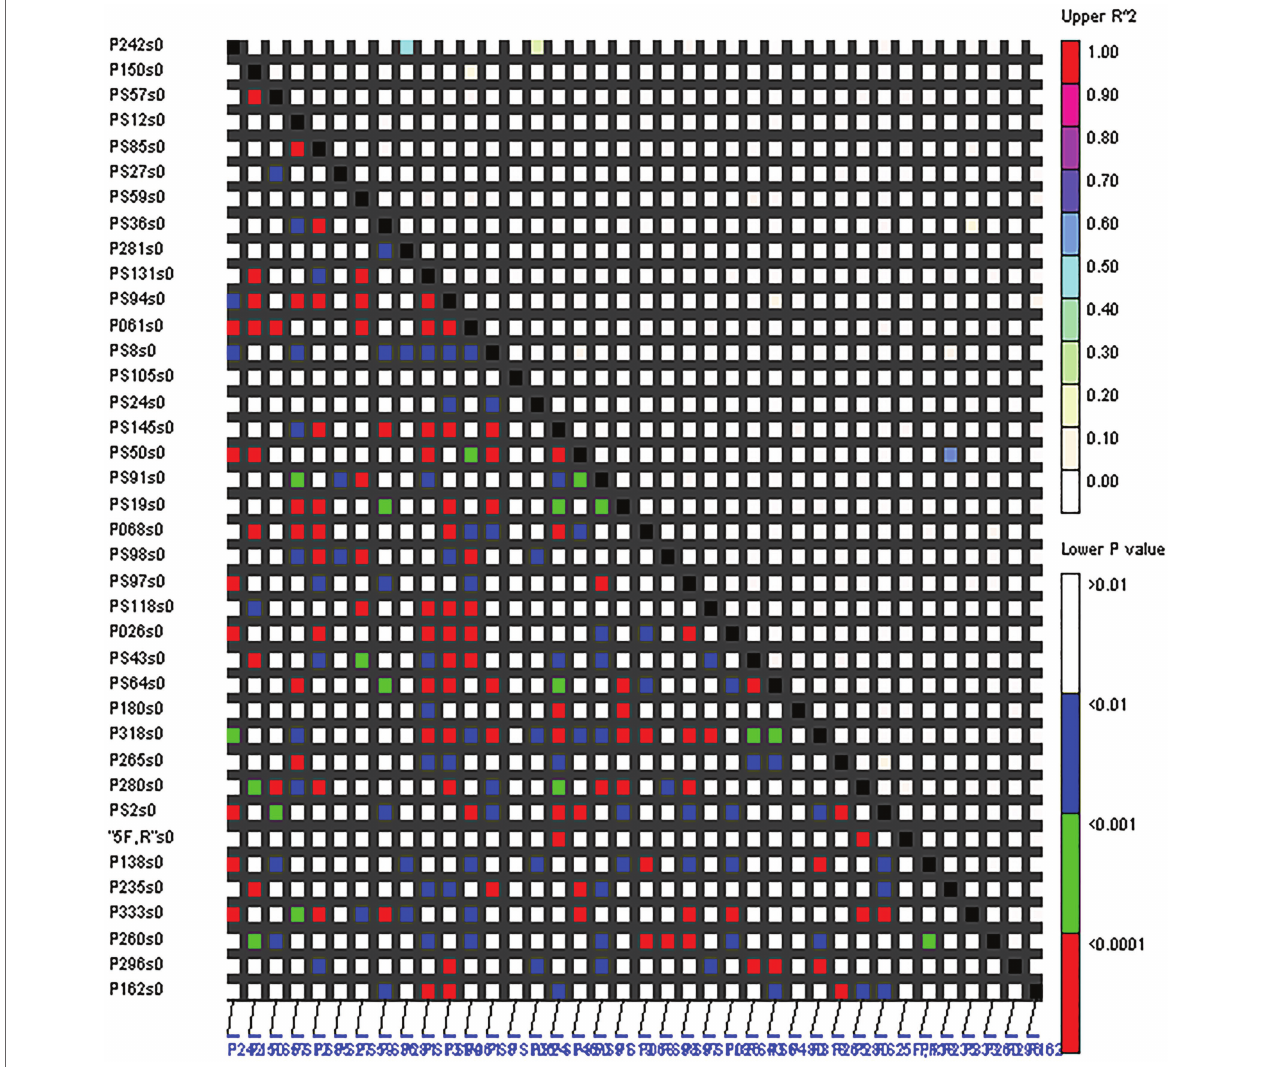
FIGURE 3 | Pairwise linkage equilibrium (LD; r 2 ) between 38 SSRs. The x - and y -axes represent the 38 SSRs, r 2 < 0.1 represents linkage equilibrium, and the different colors correspond to the thresholds of r 2 and p